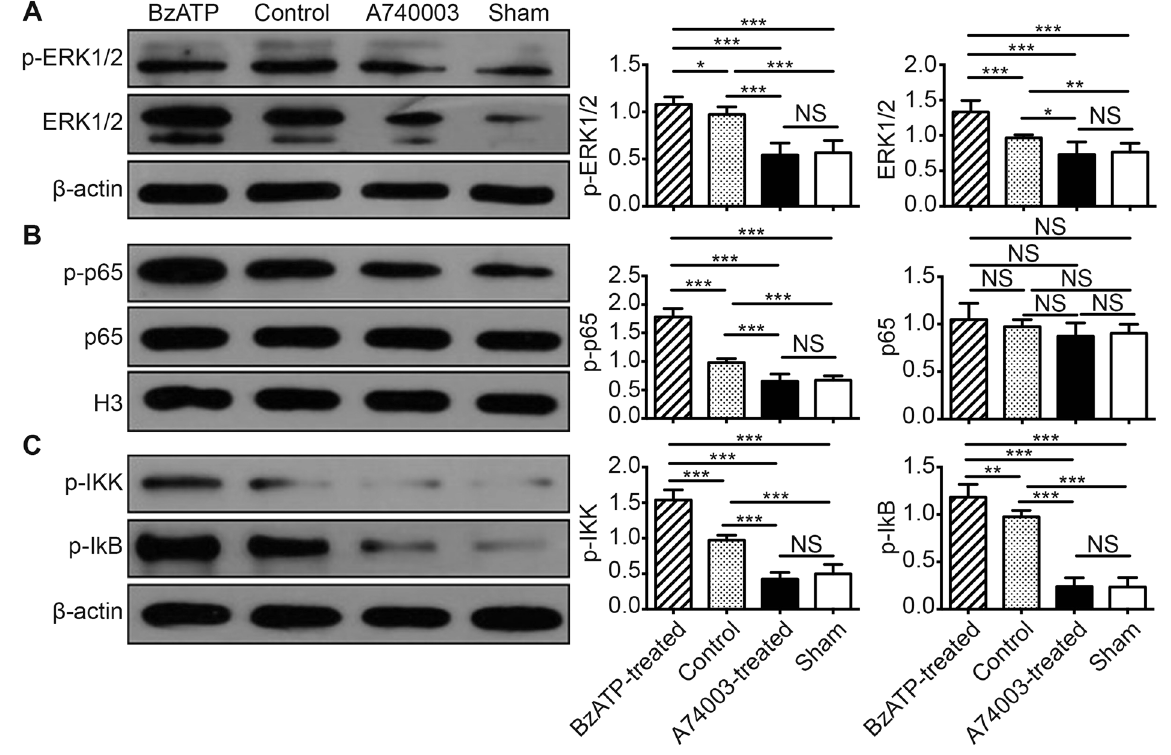
Figure 8. The effects of a P2X7R blockade on the ERK and NF- κ B pathways. The protein levels of p-ERK 1/2 and ERK 1/2 ( A ), NF- κ B p-p65 and p65 ( B ), and p-IKK and p-I κ B ( C ) in intestinal mucosa were measured by WB at 48 hours after CLP. N = 6 mice per group. The results of WB analysis are combined data from three densitometric scans (means ± SD). * p < 0.05, ** p < 0.01 and *** p < 0.001 when compared among the different